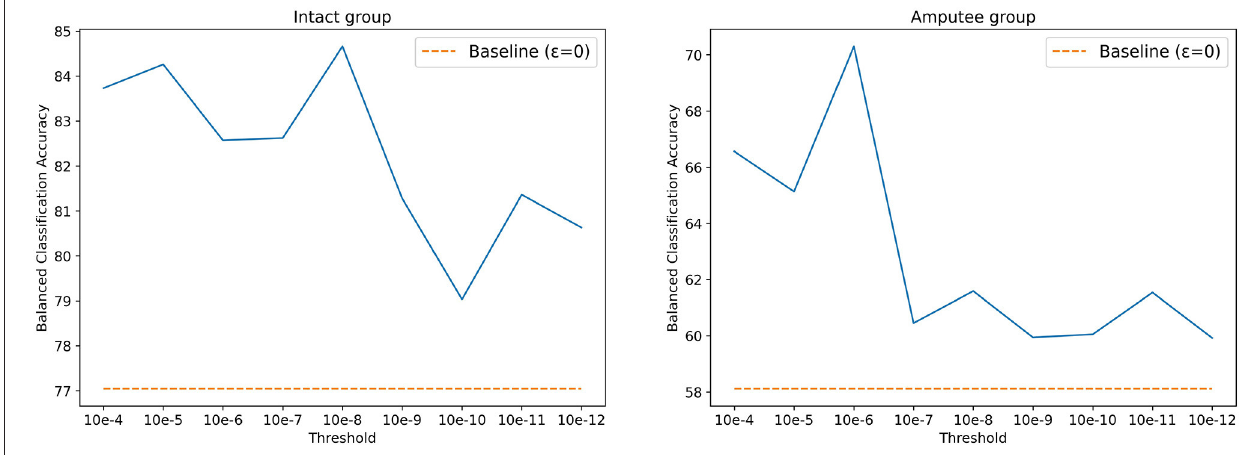
FIGURE 4 | Balanced classification accuracy at different thresholds for the intact and amputee groups from DB7.